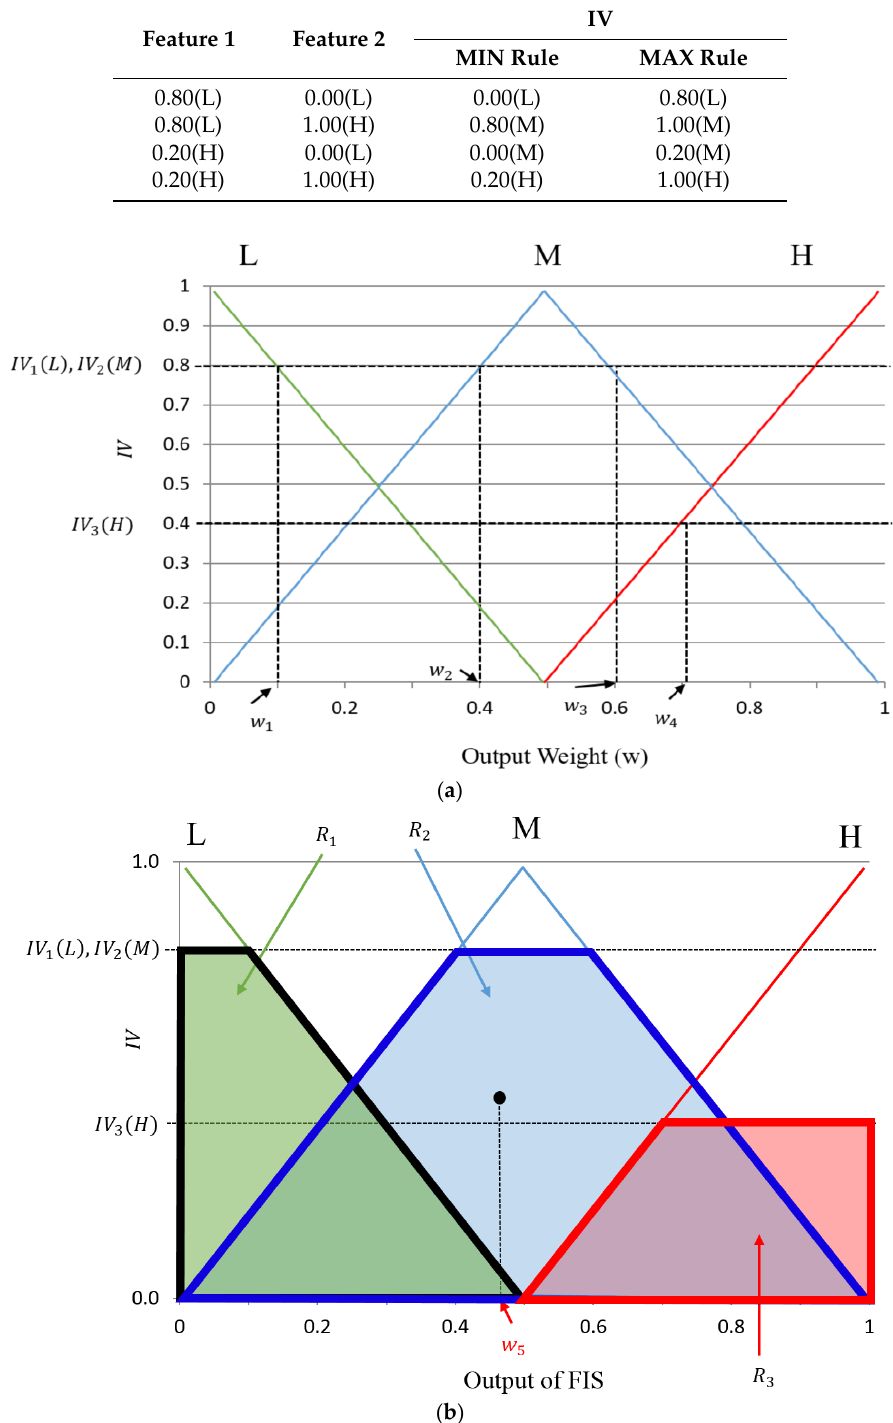
Figure 12. Output score values of FIS using defuzzification methods. ( a ) FOM, LOM, and MOM; ( b ) COG.